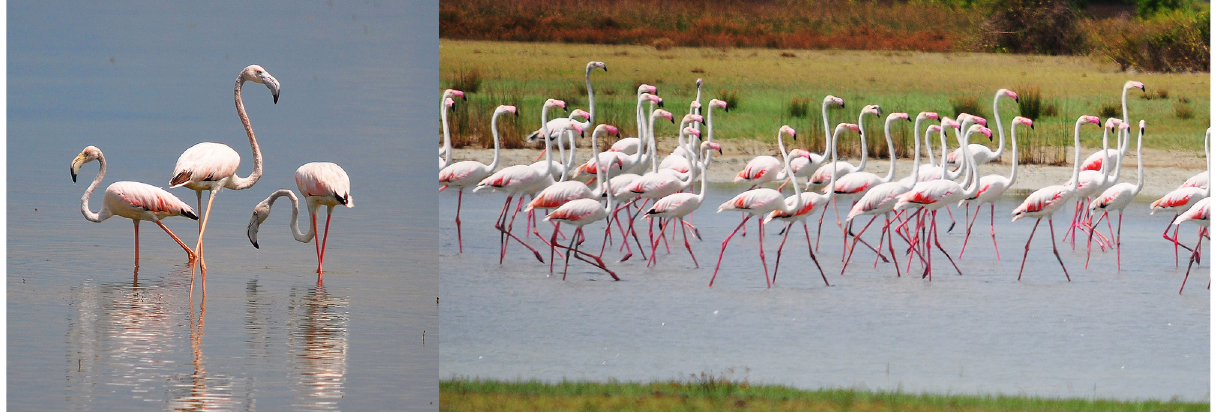
Figure 1: Flocks of Greater Flamingos in Mankumban (9º 38’ N; 79º 56’) and Vallai (9º 47’; 80º 08’) in the Jaffna Peninsula; May 2017. Photo Credit: Chaminda S.